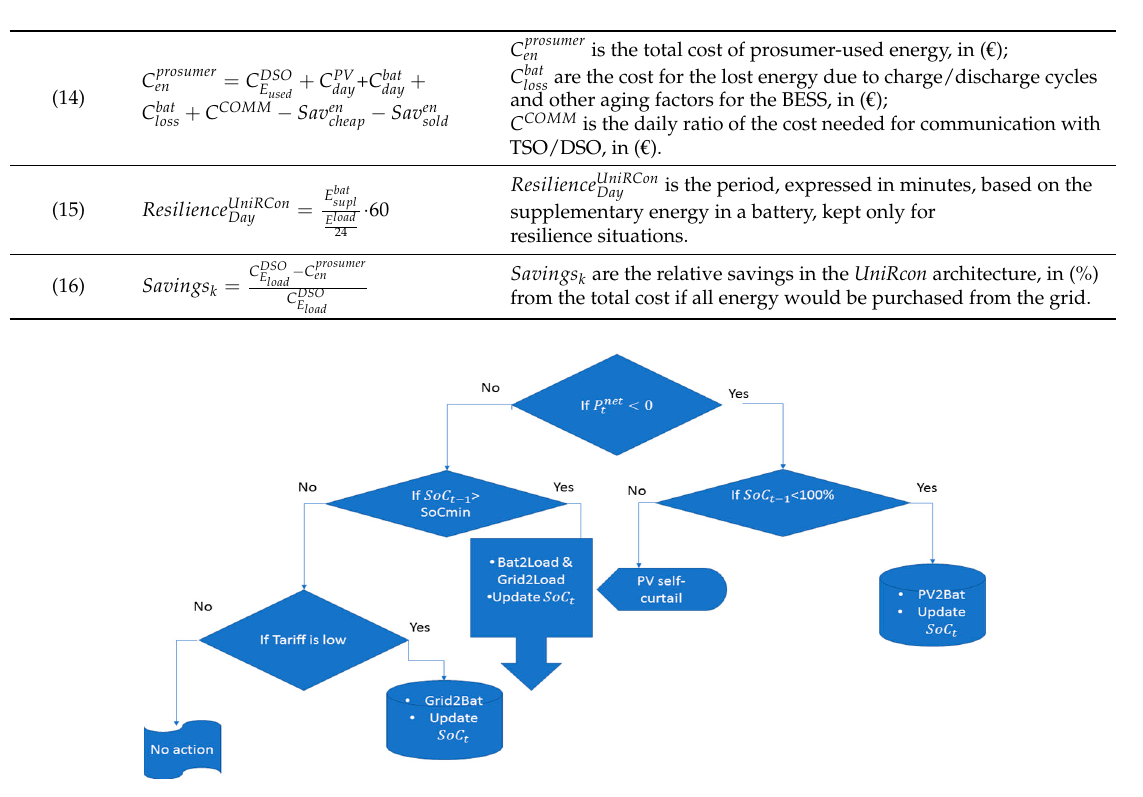
Figure 7. Decision logic for scheduling the battery operation under a predefined capacity of the battery.